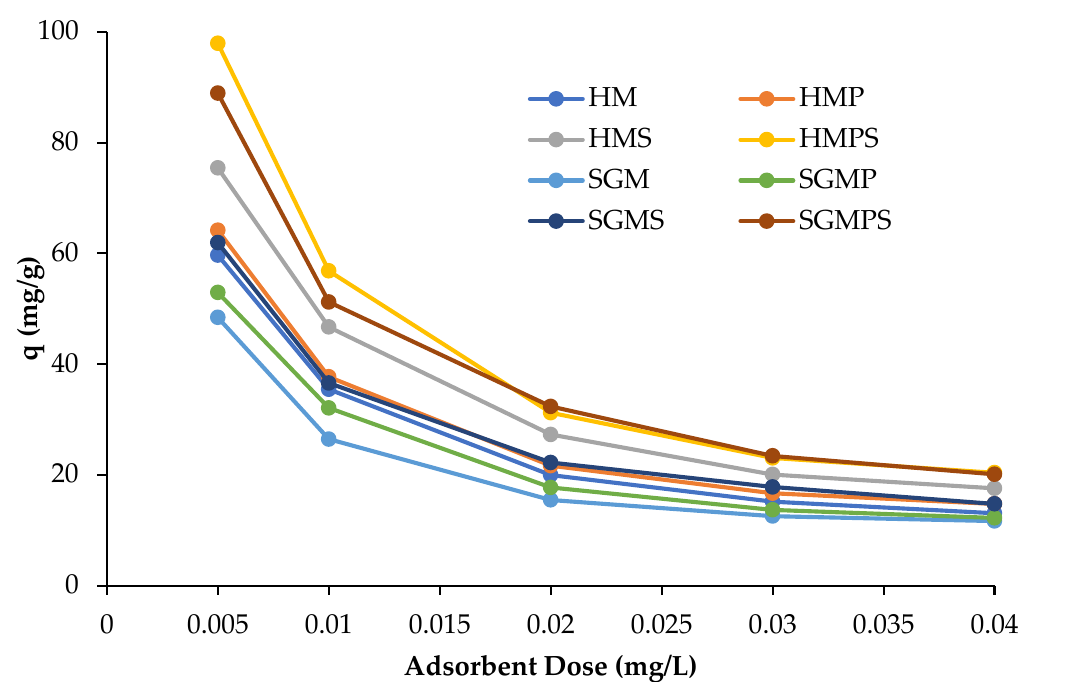
Figure 3. Effect of adsorbent dose on direct violet 51 adsorption by various materials.